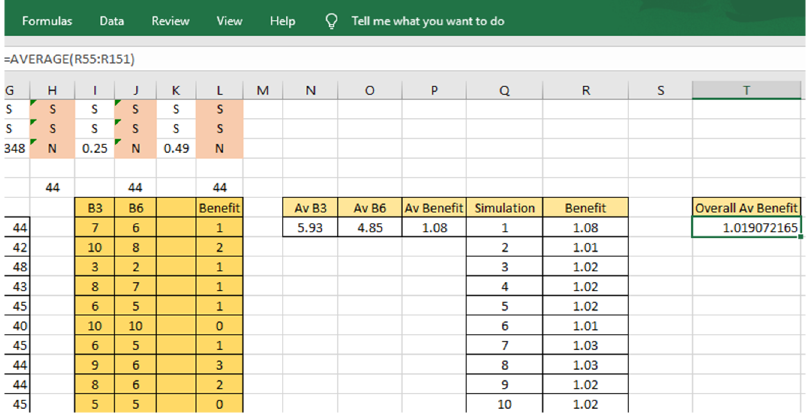
Figure 5. Overall average benefit (OAB) for average benefit of bread.